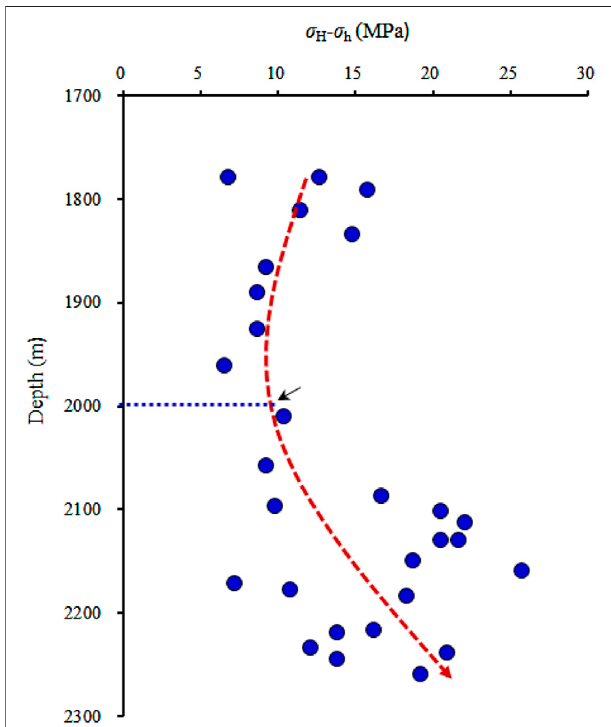
FIGURE 6 | Variation characteristics of horizontal principal stress difference with depth in the target